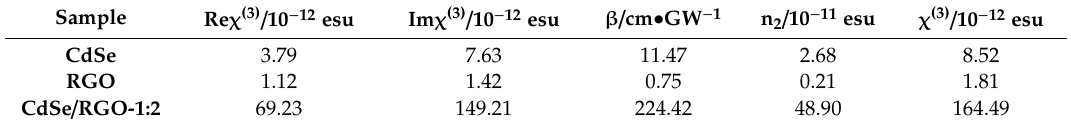
Table 1. The nonlinear optical parameters of the CdSe, RGO and CdSe / RGO composite materials.